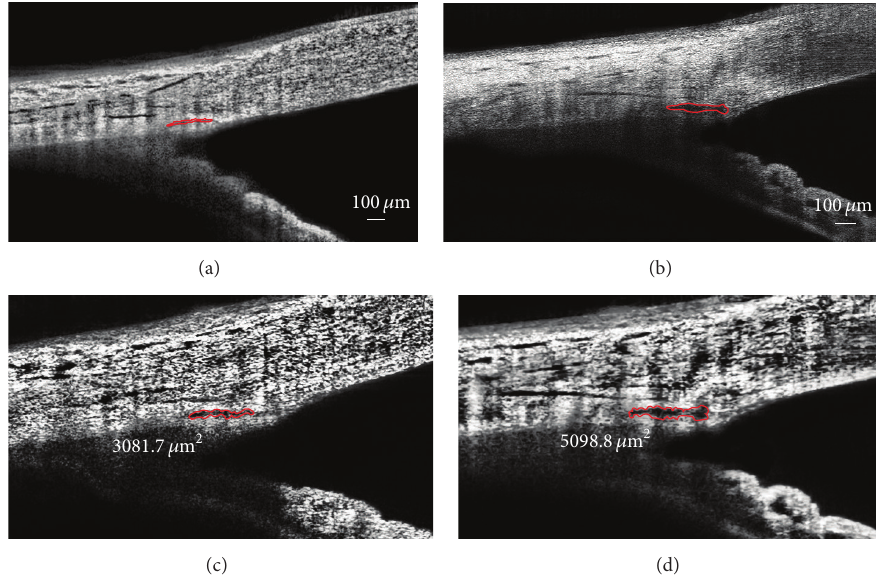
Figure 2: Anatomical changes of SC before ((a), (c)) and after ((b), (d)) phacocanaloplasty. Visualization was maximized by adjusting contrast and magnification using ImageJ program ((c), before surgery, and (d), after surgery).